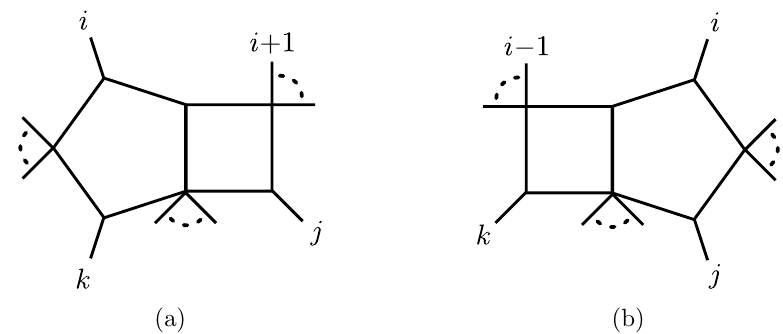
Figure 7. Landau diagrams corresponding to all of the cut conditions (3.7){(3.9) except for (a) hL (1) i (cid:0) 1 i i = 0, and (b) hL (2) i i +1 i = 0. These are the only two cut conditions that are redundant (each is implied by the other eight, for generic kinematics) and, when omitted, lead to Landau diagrams that have the form of a standard Feynman integral. (In both (cid:12)gures L (1) is the momentum in the right loop and L (2) is the momentum in the left